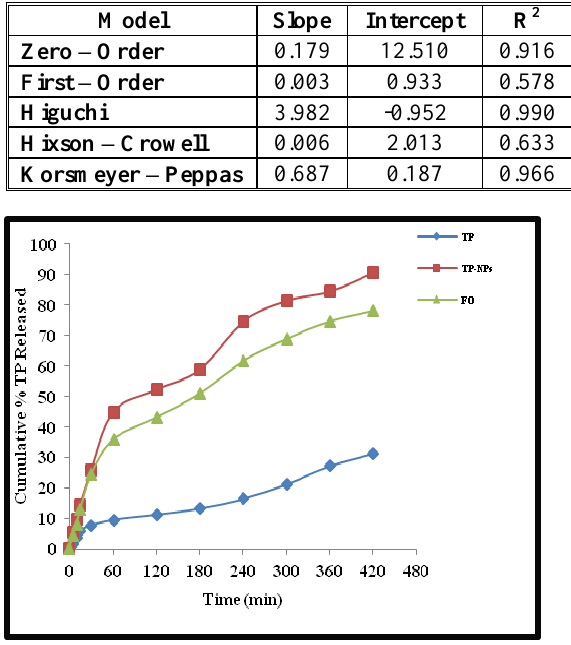
Figure 10: in vitro release profiles of TP, TP – NPs and F O Differential scanning